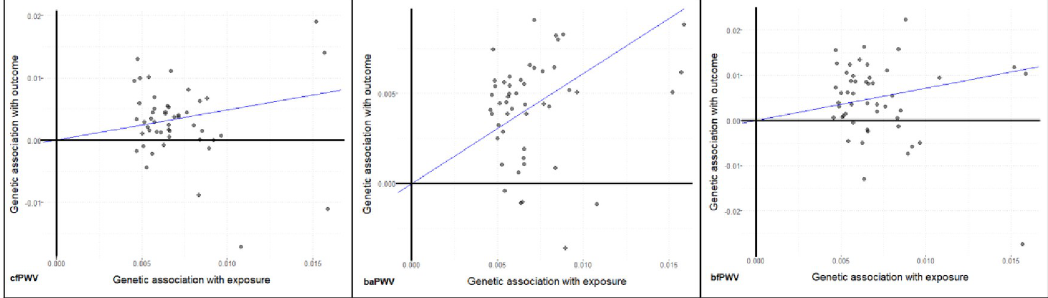
Fig 4. Mendelian Randomization (IVW method): Blood pressure SNPs reported by Evangelou with p-value of less than 0.05 for SPB (and no association with PWV) in our study population were considered as instruments. We report their effect on cfPWV (left), bfPWV (middle) and baPWV (right). Abscissa shows genetic association with BP; ordinate shows genetic association with PWV.